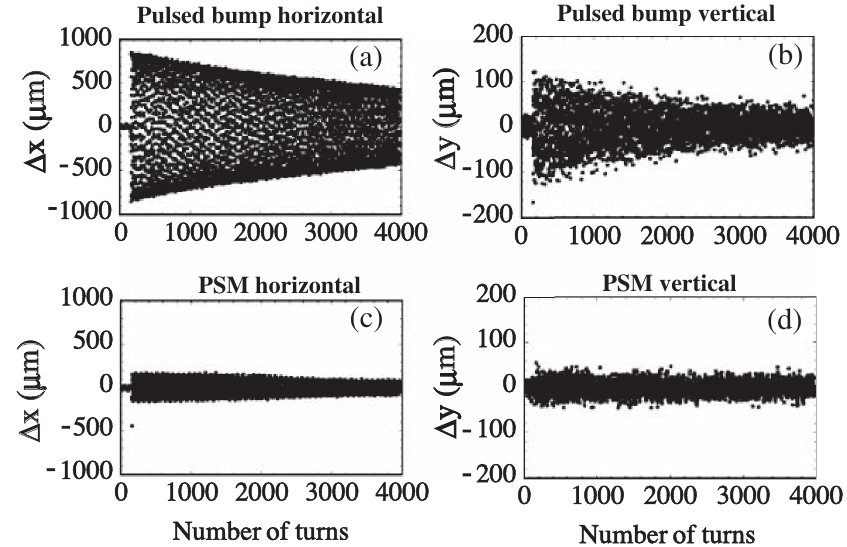
FIG. 20. Horizontal and vertical beam oscillations ( (cid:1) x and (cid:1) y ) of the stored beam immediately after injection. The oscillations produced by the pulsed bump are shown in the upper two figures, (a) and (b), and those by the PSM are in the lower two figures, (c) and (d).